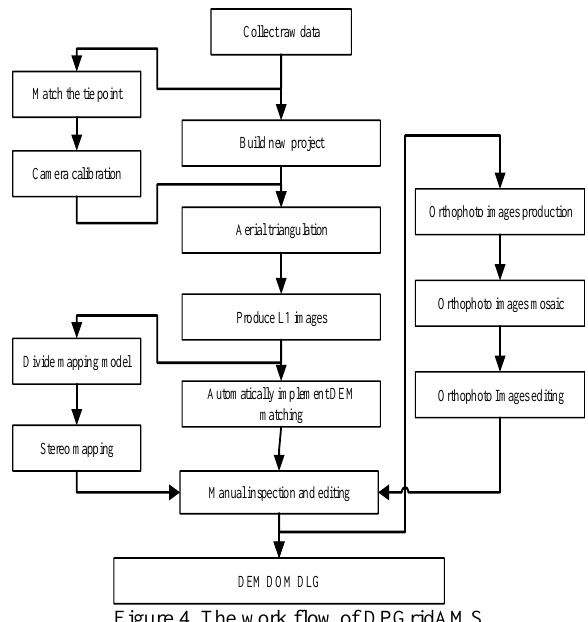
Figure 4. The work flow of DPGridAMS